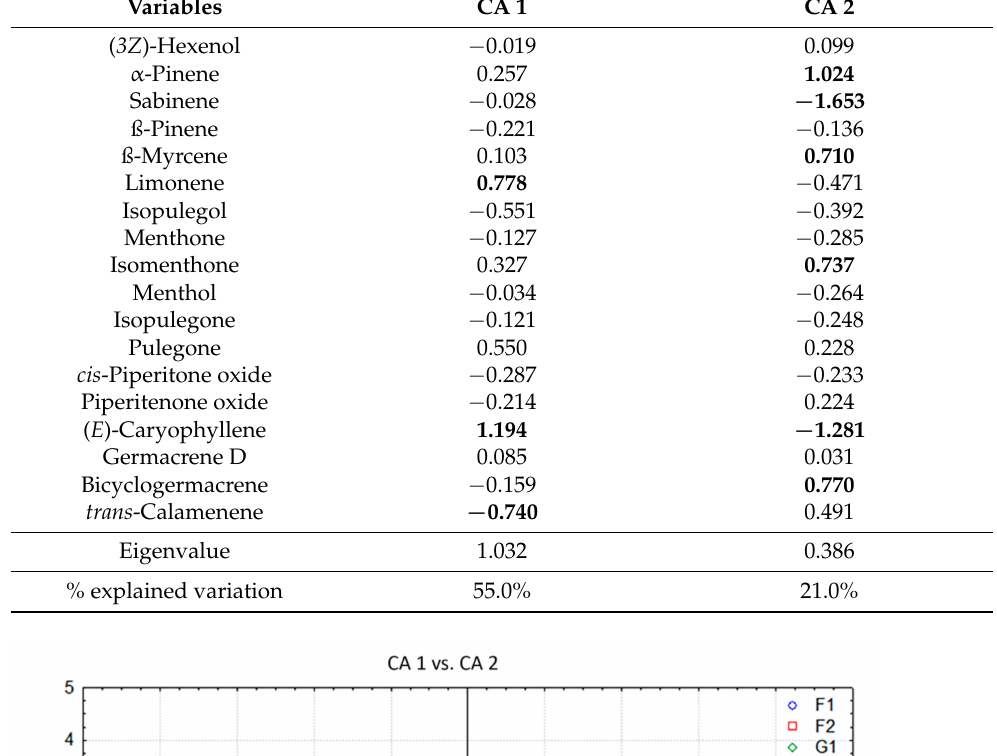
Standardized coefficients for the first two canonical axes (CA) of variation in 18 Clinopodium pulegium HS volatiles from the discriminant functional analysis of six a priori groups. Significant coefficients are in boldface.